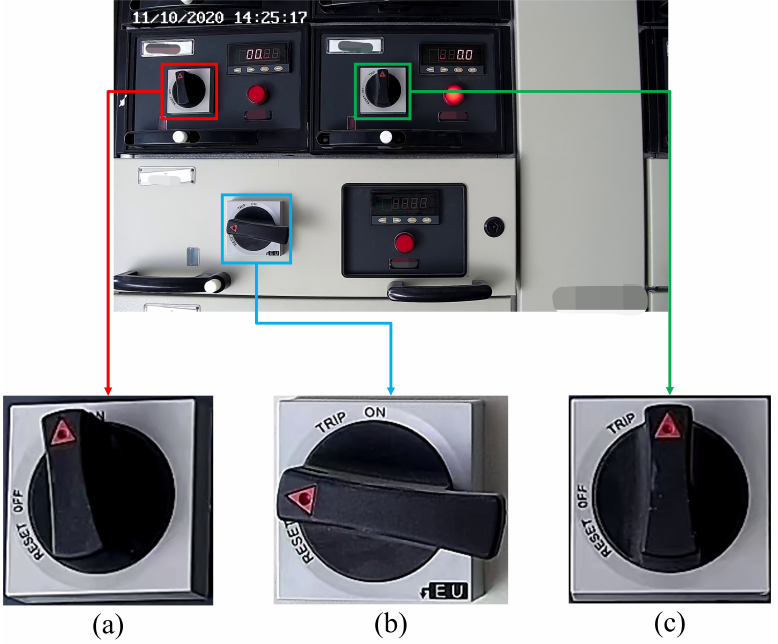
Figure 2. Collected original image at the substation site. ( a ) The oblique view where the actual direction is up and is misjudged as the upper left direction. ( b ) The oblique view where the actual direction is left and is misjudged as the upper left direction. ( c ) Front